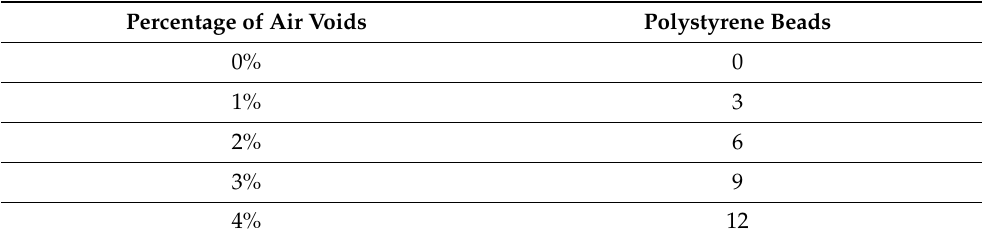
Table 1. Approximate number of added polystyrene beads.